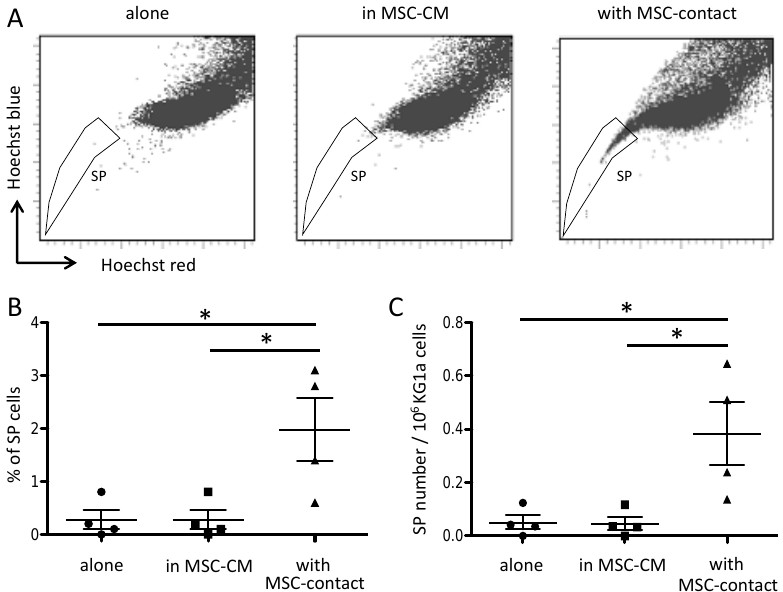
Figure 2. Contact with MSCs increases SP proportion in leukemic cells. SP was assessed by Hoechst efflux measurement in flow cytometry. Cytograms in ( A ) illustrate a representative acquisition of Hoechst staining of KG1a leukemic cells after a 72 h culture alone (left panel), in MSC-CM (middle panel), or with MSC-contact (right panel). Quantitative results are shown as SP percentages ( B ) absolute numbers ( C ) in the three culture conditions ( n = 4). * p < 0.05.